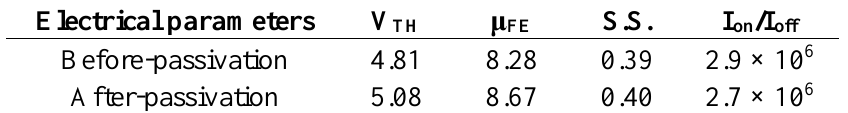
Figure 2. ( a ) Transfer curves (I DS –V GS ) of a-IGZO TFTs without teflon buffer layer; ( b ) Transfer curves (I DS –V GS ) of a-IGZO TFTs before and after Teflon/SiO 2 bilayer deposition. Table 1. The electrical characteristics of devices before and after Teflon/SiO 2 bilayer